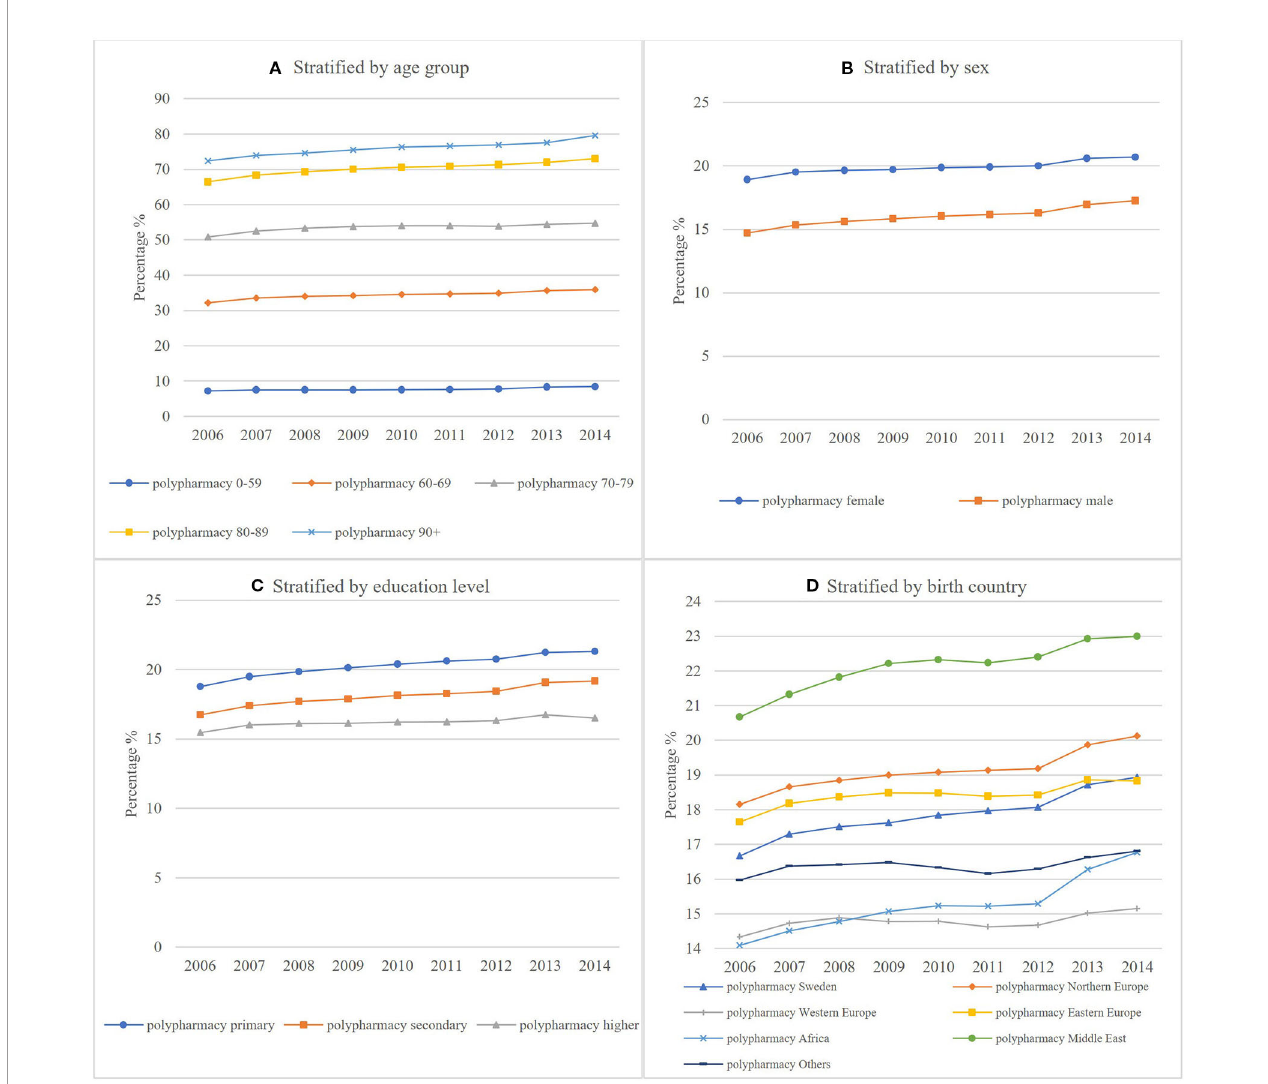
FIGURE 1 | Age-standardized rate of polypharmacy strati fi ed by (A) age group (B) sex (C) education level (D) birth